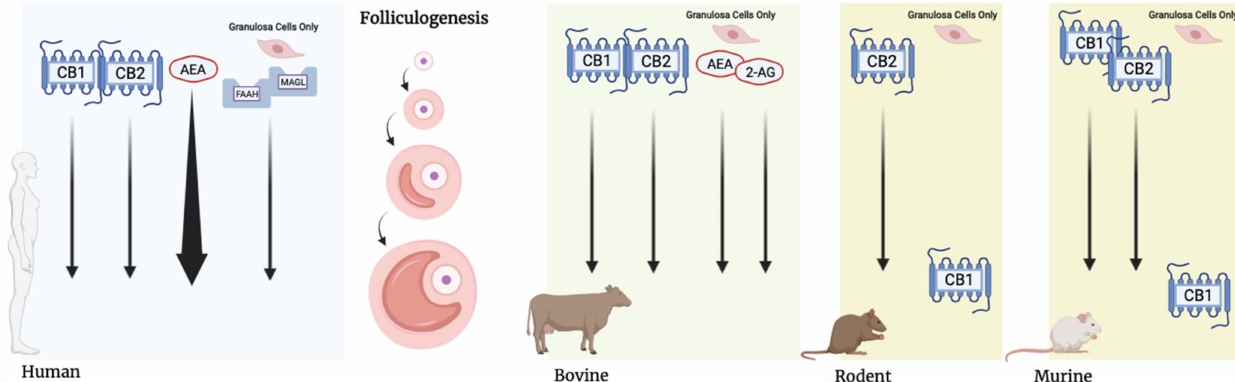
Figure 3. Localization of the endocannabinoid system within ovarian follicles of several mammalian species. CB1 and CB2 are detected in human, bovine, and murine follicles throughout development. Detection of CB1 receptors in rodent specimens have been limited to the granulosa cells of Graafian follicles. CB1 receptors have been detected in the granulosa cells of Graafian follicles in mice. AEA levels in human follicles increase throughout folliculogenesis, peaking in Graafian follicles. Both AEA and 2-AG have been detected in granulosa cells of all follicles. MAGL and FAAH are detected in granulosa cells throughout folliculogenesis in humans.